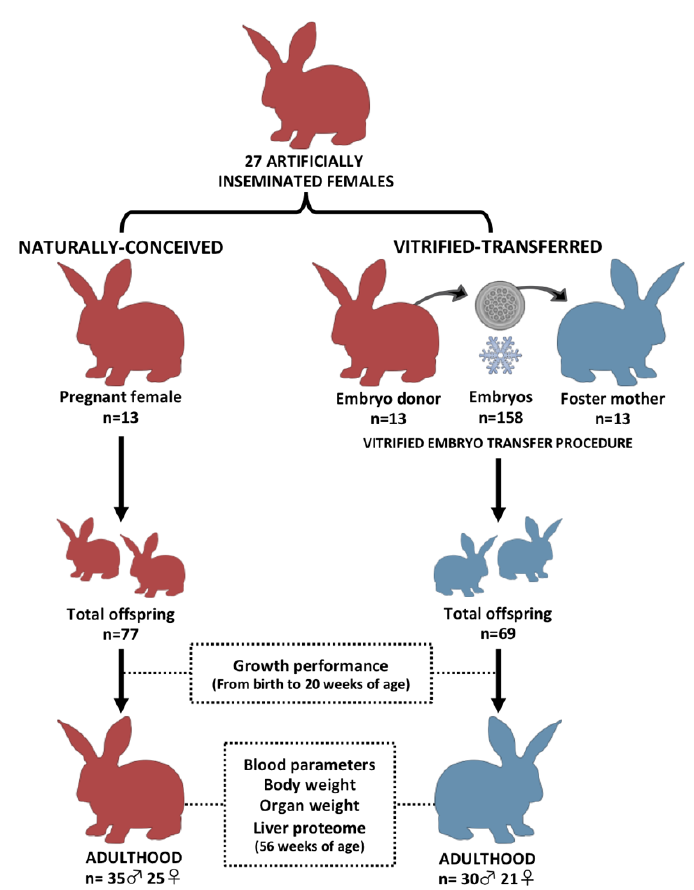
Figure 1. Experimental design. Two experimental progenies were developed and compared during development and in adulthood. Vitrified-transferred population arises from vitrified embryos transferred into foster mothers; meanwhile, the naturally conceived population was generated without embryo manipulations. In both groups, after parturition day, offspring were weighed every week until adulthood (growth performance). In adulthood, peripheral blood parameters and organ weight comparisons were performed in male animals. From liver samples, a proteomic comparative analysis was developed. n: number of animals.